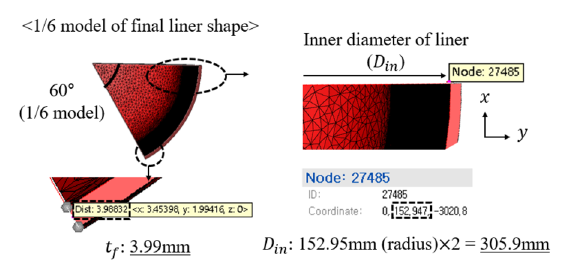
Figure 16 Dimensions of the final liner shape after 3rd stage